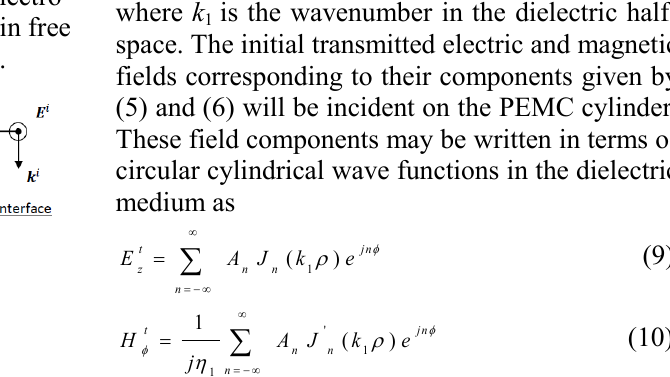
Fig. 1. Geometry of the buried PEMC cylinder located in a dielectric